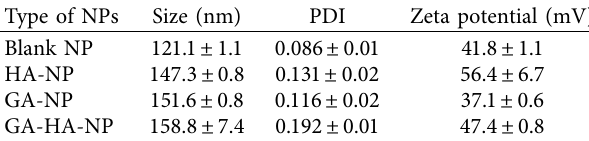
Table 3: Characterization of NPs.